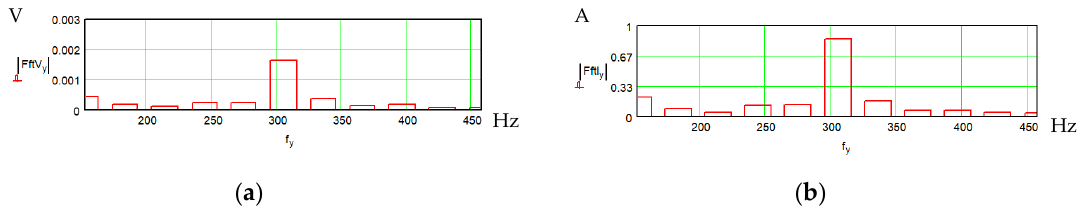
Figure 3. Fast Fourier transform (FFT) of the voltage ( a ) and current ripple ( b ).